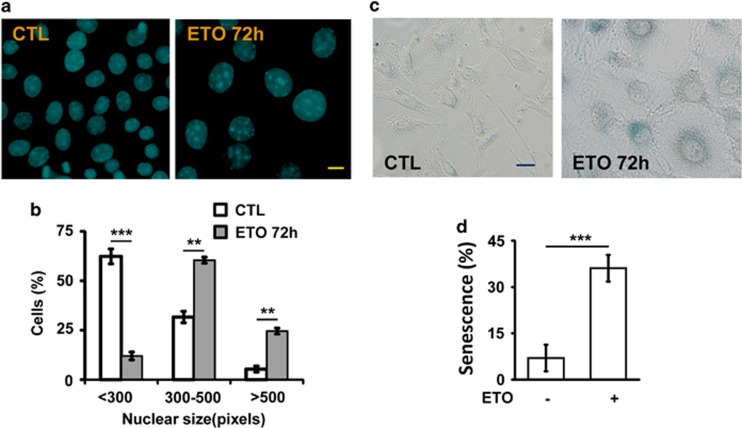
Long-term sublethal dose of ETO treatment induces genomic instability and cellular senescence. (a and b) Enlarged nuclei are observed in ETO-treated (10 μM, 72 h) adrenocortical Y1 tumor cells. (a) Examination of nuclear size by DAPI staining. The scale bar is 5 μm. (b) Quantitation of nuclear areas. The areas of nuclei from at least 100 Y1 cells in (a) were counted and compared in three independent experiments. (c and d) Cellular senescence are observed in ETO-treated adrenocortical Y1 tumor cells. (c) Cellular senescence is shown by beta-galatosidase activity after ETO treatment for 72 h. (d) Quantitation of cells with beta-galatosidase activity. These results are mean +/−s.d. from three independent experiments; more than 100 cells were counted in each individual group. Scale bar is 5 μM. **P<0.01, ***P<0.001.